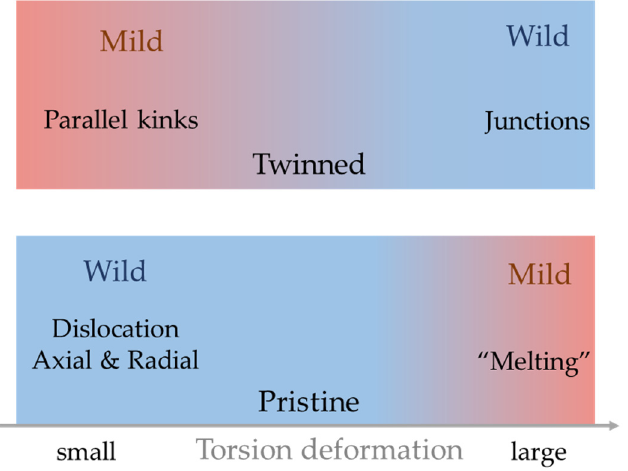
Figure 8. Comparison the deformation dynamics of twinned and pristine α -Fe nanowires under torsion.